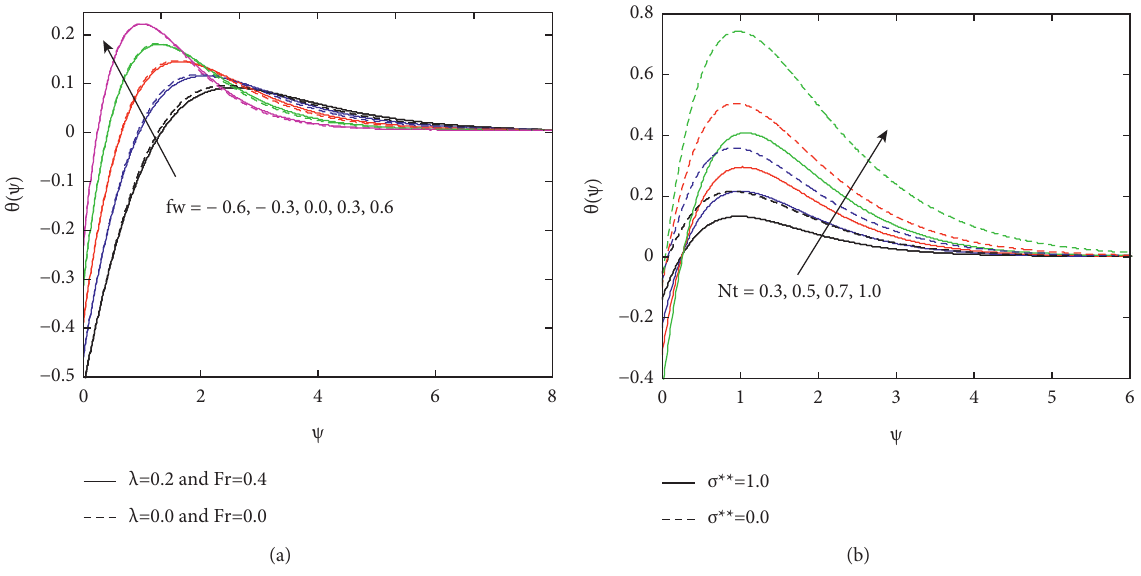
Figure 7: The nanofluid concentration distribution for diverse quantity of fw (a) and Nt (b).